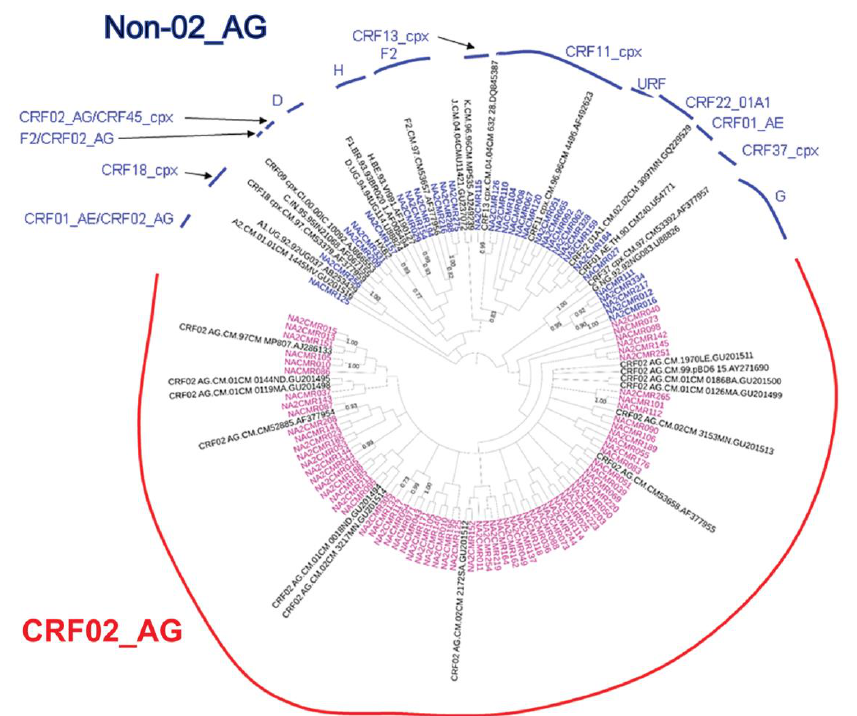
Figure 2. Phylogenetic analysis of HIV-1 nef gene sequences in cohort samples. The maximum likelihood phylogenetic tree was constructed using the MEGA 6 software package as described in Materials and Methods. The 31 reference sequences were from the Los Alamos database and included HIV-1 isolates from nine different countries [Belgium (1), Brazil (1), Cameroon (22), Cote D'Ivoire (1), India (1), France (1), Nigeria (1), Uganda (2), and United Arab Emirates(1)]. Bootstrap values of 1000 replicates (>70%) are shown at the corresponding nodes.